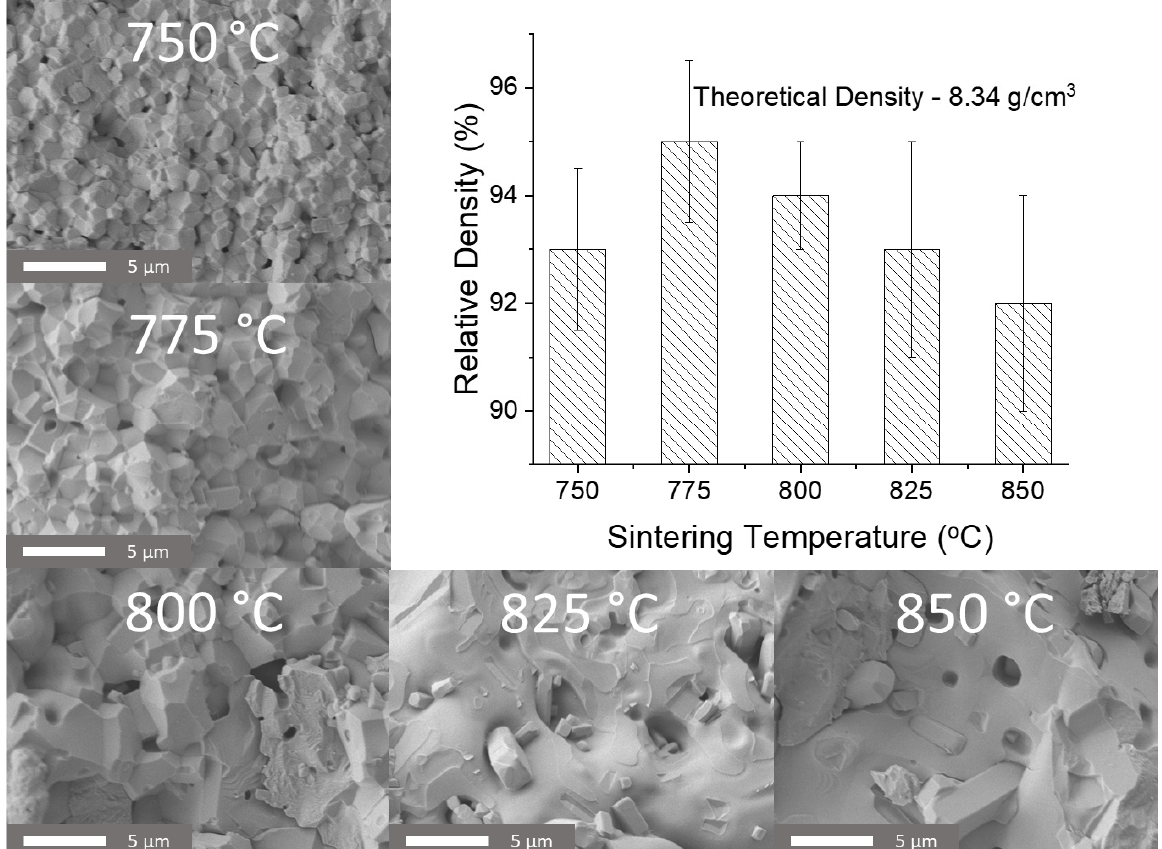
Figure 3. SEM micrographs of structure and density values for ceramics sintered from stoichiometric precursors at different temperatures.